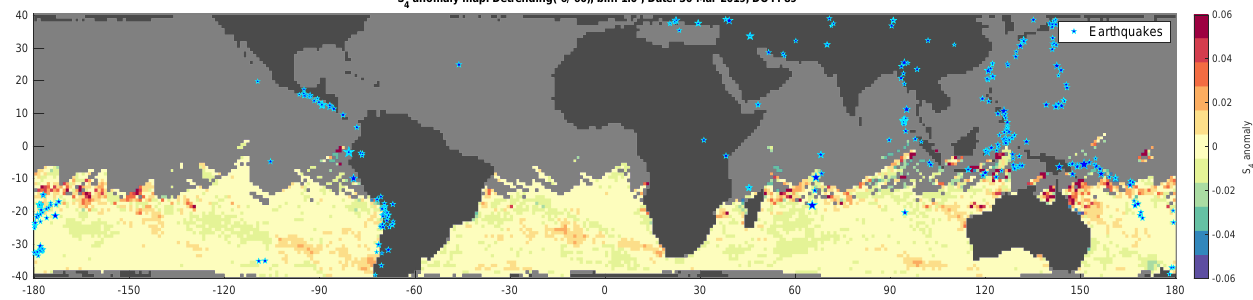
Figure 9. S 4 variations map for one of the minimum coverage days, from − 40º to around − 5º in